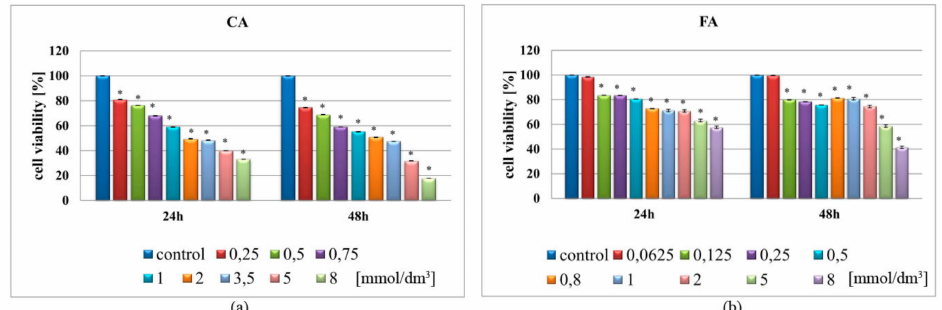
Figure 1. E ff ect of cinnamic acid (CA) and ferulic acid (FA) on the viability of human glioblastoma LN-229 cells. Cells were treated for 24 h and 48 h with the indicated concentrations of CA ( a ) and FA ( b ). The viability of cells was determined using the metabolic activity-assessing tetrazolium test (MTT) assay. The results represent means for pooled triplicate values from three independent experiments. * indicates statistical significance ( p -value < 0.05) when comparing to untreated control